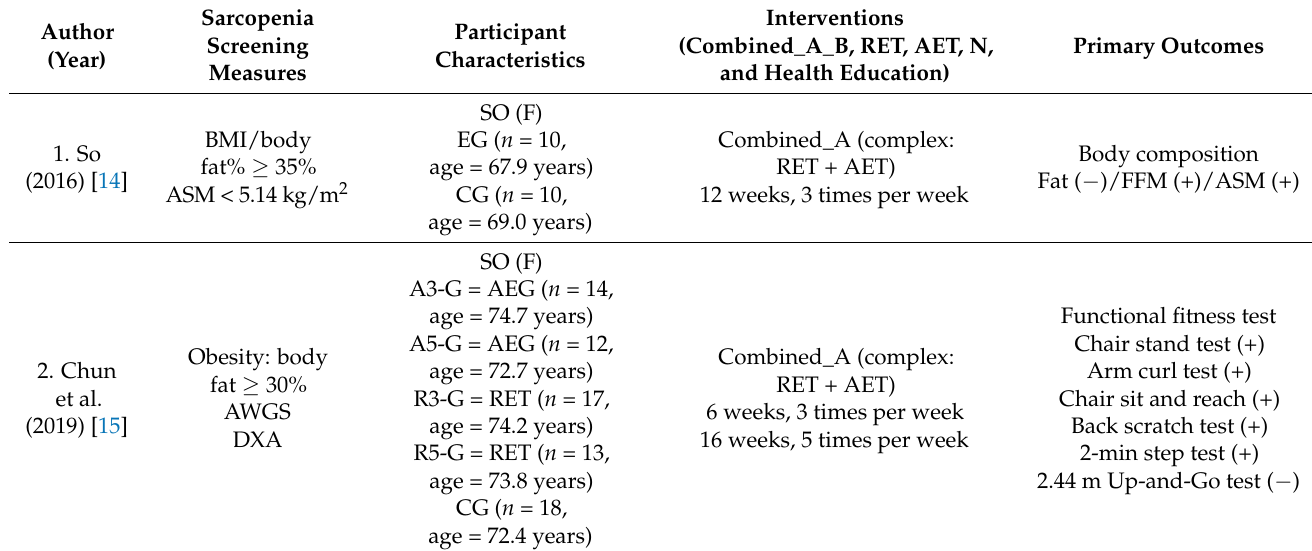
Table 1. Characteristics of studies included in our systematic